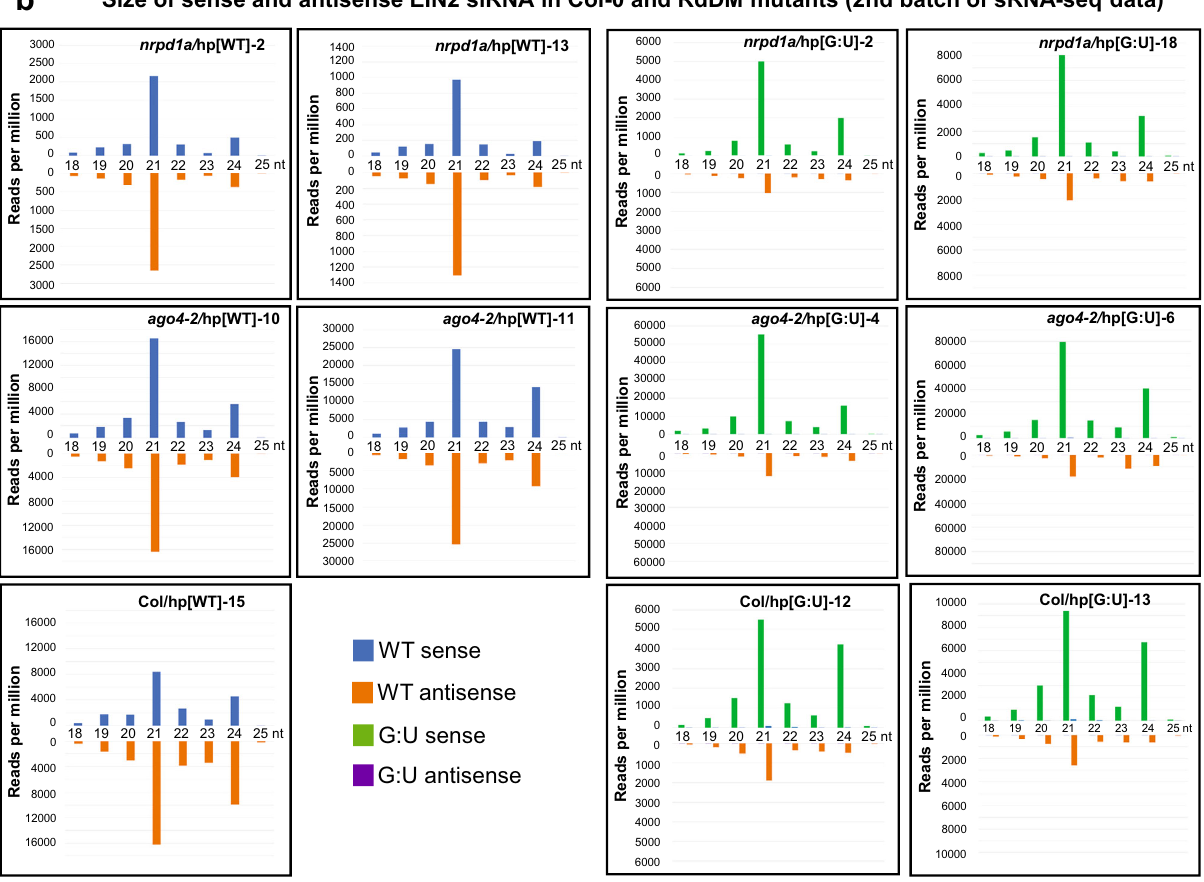
Fig. 8 Summary of sRNA deep sequencing data. Size distribution of sense and antisense siRNAs derived from the dsRNA stem of the hpEIN2[WT] and hpEIN2[G:U] in Col-0 ( a , b ), nrpd1a-3 and ago4-2 ( b ) backgrounds is shown. Note that for the G:U hpRNA lines, the bulk of the sense siRNAs have the C to U converted sequence of the sense strand, indicating little or no RDR-synthesized secondary